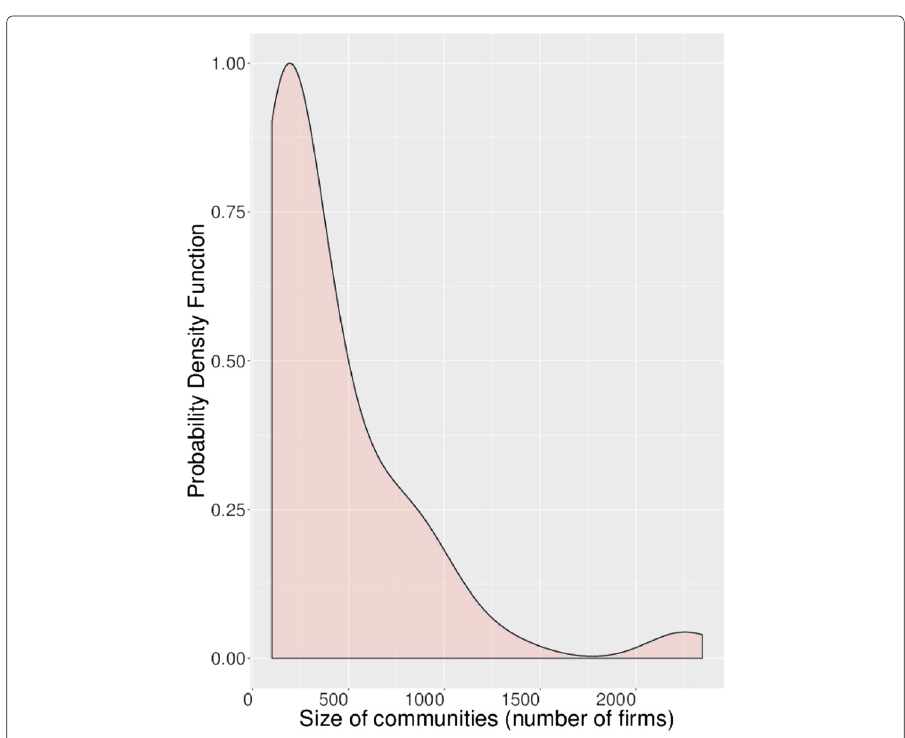
Fig. 1 The size distribution of the studied communities. The size of a community is expressed as the total number of firms of which it consists